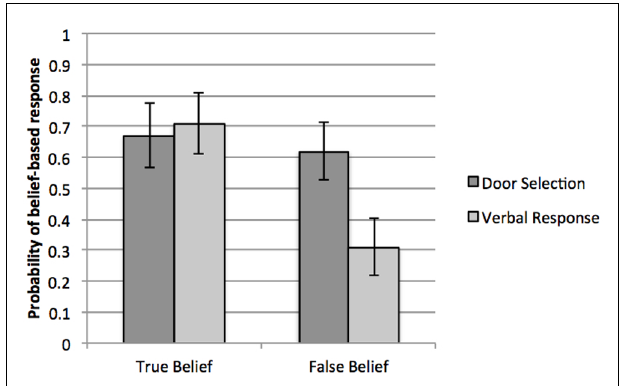
FIGURE 2 | Probabilities of responses consistent with the actor’s beliefs by response measure, for the single trial per child where they completed both